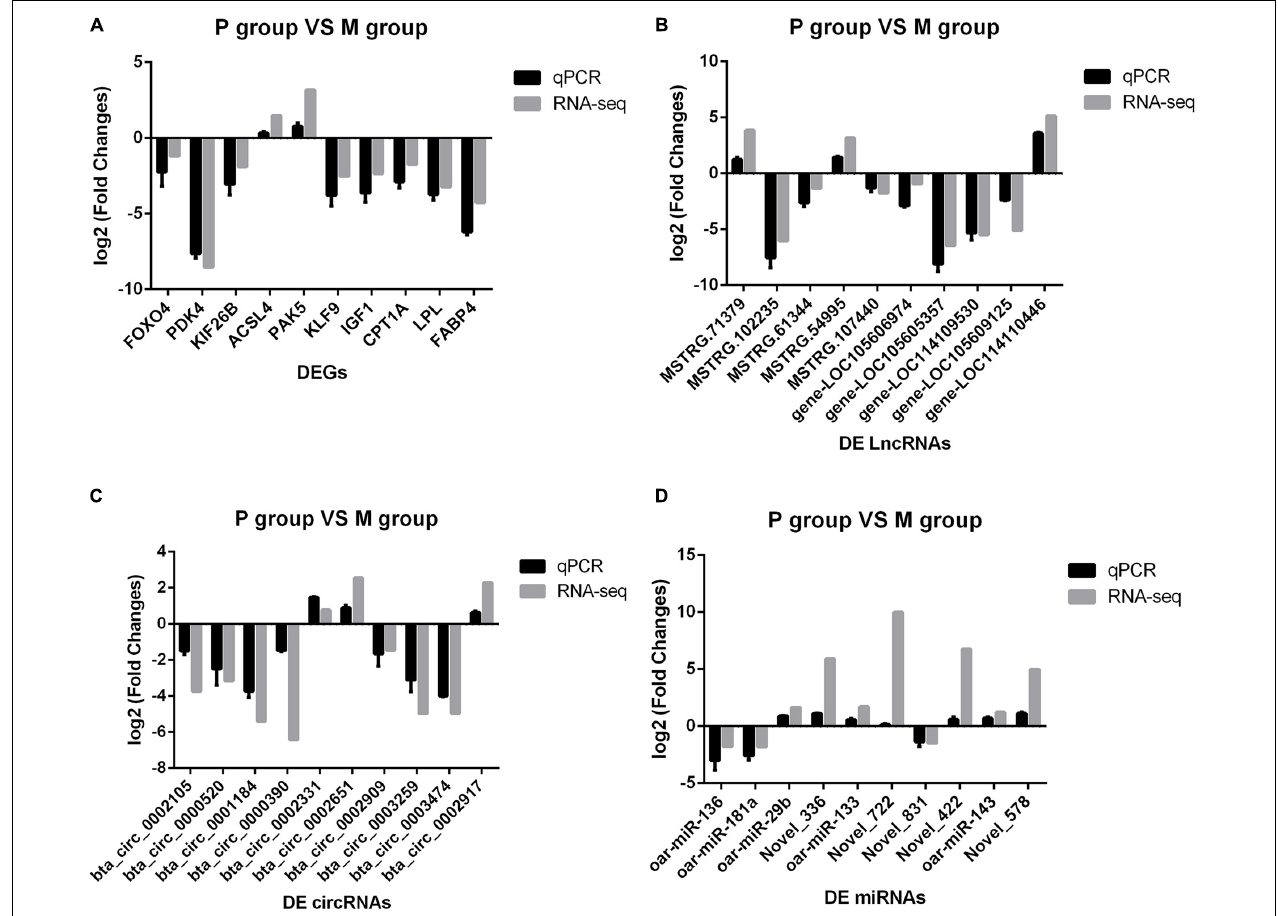
FIGURE 4 | Comparison of sequencing results and qPCR results. The abscissa is differentially expressed RNAs (DERs), the ordinate is Log2(Fold Change), the gray column is the sequencing result, and the black column is the qPCR result. (A) Validation of messenger RNA (mRNA) results by qPCR. (B) Validation of long non-coding RNA (lncRNA) results by qPCR. (C) Validation of circular RNA (circRNA) results by qPCR. (D) Validation of microRNA (miRNA) results by